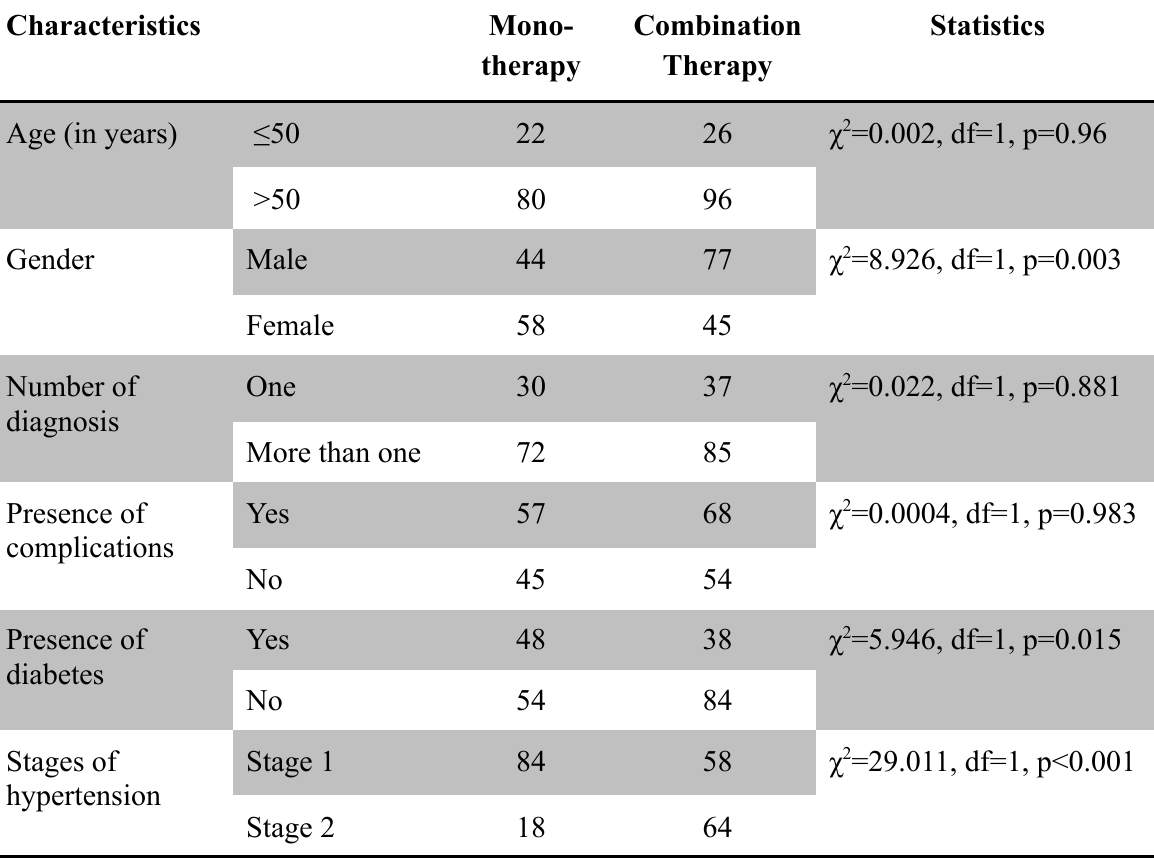
Table 5: Association of socio-demographic and clinical characteristics with monotherapy or combination therapy of hypertension (N =